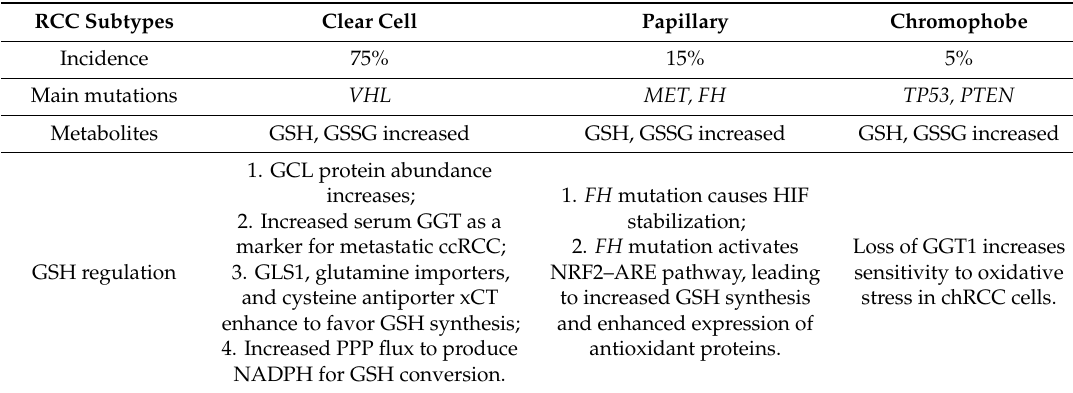
Table 1. Summary of the three renal cell carcinoma (RCC) subtypes, incidences, main mutations, and GSH